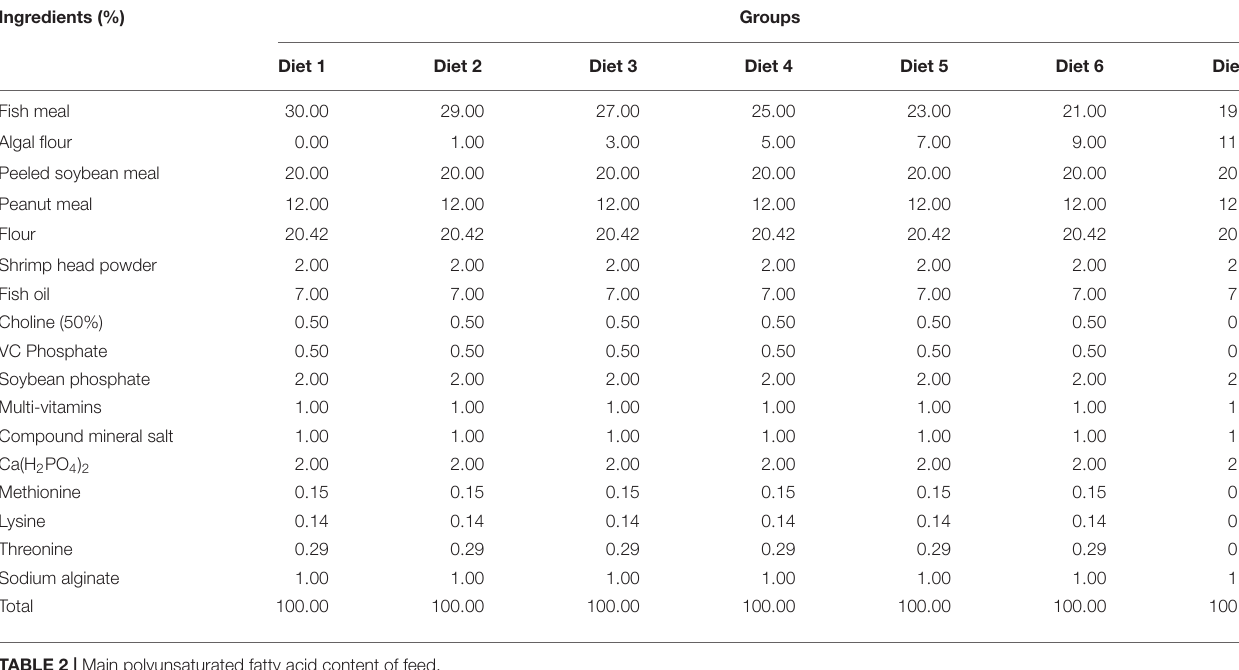
TABLE 1 | Ingredients and proximate composition of experimental diets.